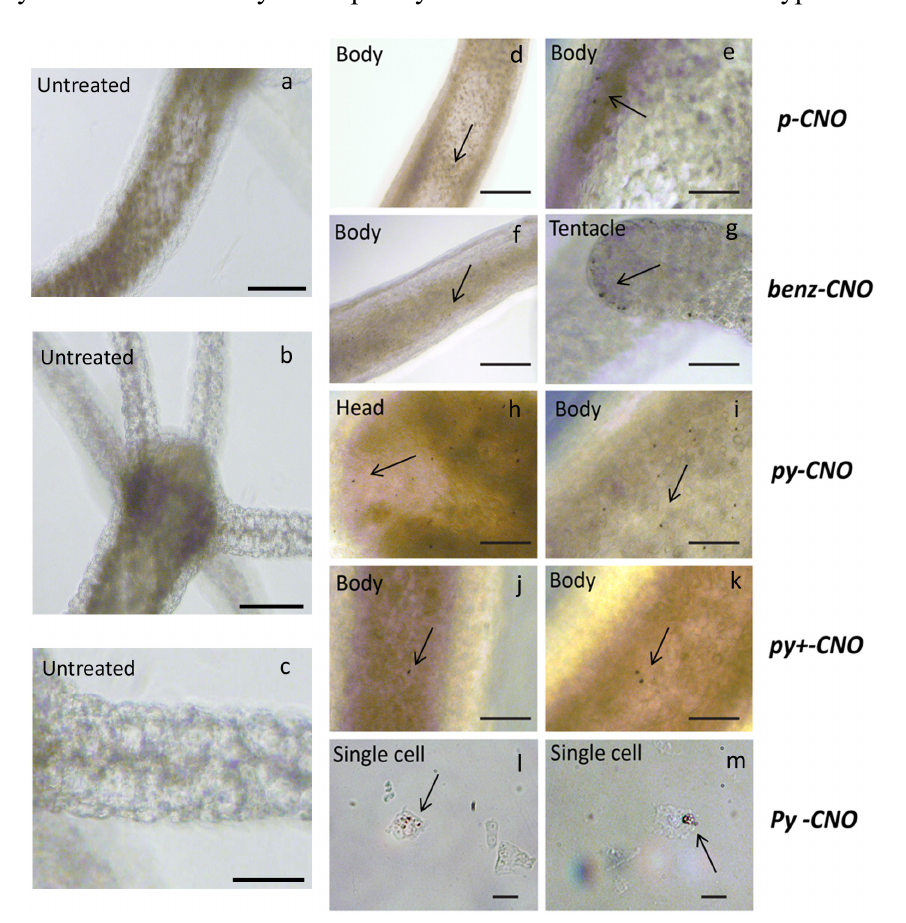
the tentacles, heads and body columns. Scale bars: 500 µm in ( f ); 50 µm in ( g ); 200